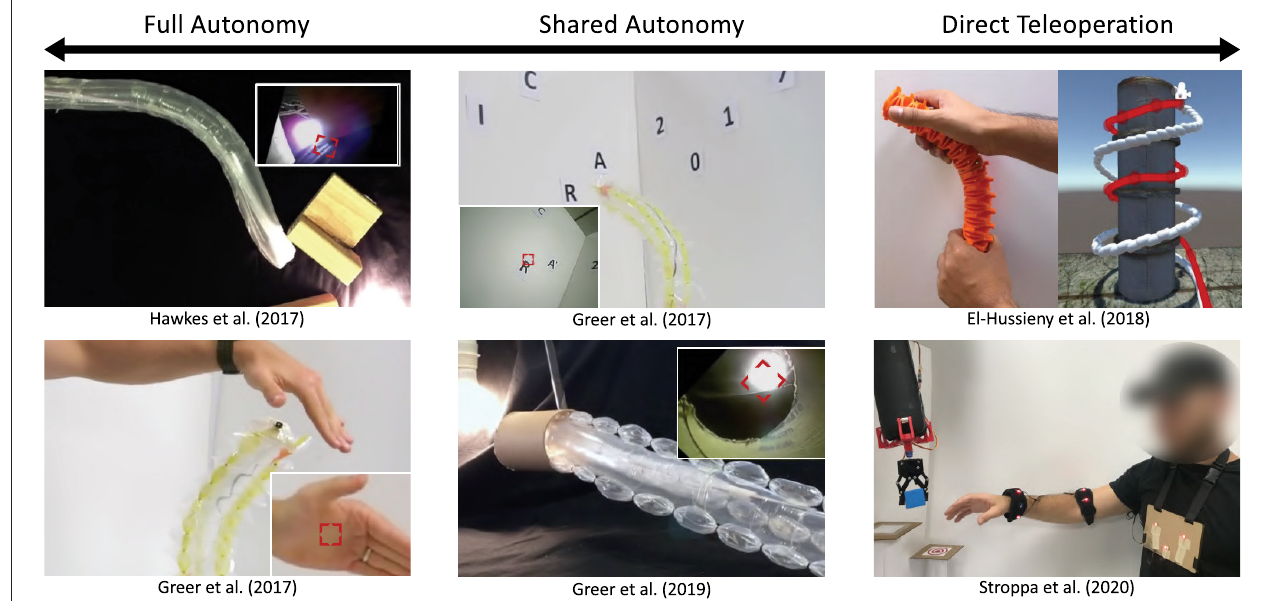
FIGURE 10 | Input modalities for everting vine robot control on the spectrum from full autonomy to direct teleoperation. (Left) Full autonomy has been demonstrated for simple tasks, such as following a continuously visible stimulus in the robot’s field of view. (Middle) Shared autonomy has used a point-and-click interface for the human operator to direct the robot toward a set of waypoints in its camera view. (Right) Direct teleoperation has used both off-the-shelf and custom-designed interfaces that are held or worn and used to complete navigation and pick-and-place tasks. Modified from Hawkes et al. (2017). Reprinted with permission from AAAS. Modified from Greer et al. (2019). The publisher for this copyrighted material is Mary Ann Liebert, Inc. publishers. Modified from Greer et al. (2017) © IEEE 2017, El-Hussieny et al. (2018) © IEEE 2018, and Stroppa et al. (2020) © IEEE 2020.